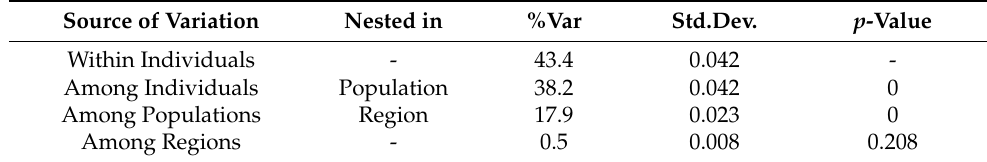
Table 1. Analysis of molecular variance (AMOVA) based on 12 microsatellites. Abbreviations are as follows: %var = percent of variance; Std.Dev. = standard deviation; p -value = probability. Source of Variation Nested in %Var Std.Dev. p -Value Within Individuals - 43.4 0.042 - Among Individuals Population 38.2 0.042 0 Among Populations Region 17.9 0.023 0 Among Regions - 0.5 0.008